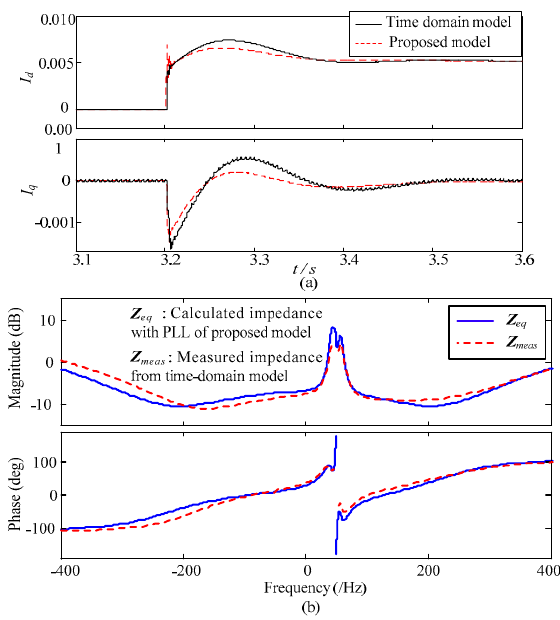
Figure 5. The comparison of the time-domain model and the proposed model: ( a ) current step responses; and ( b ) VSC impedance in stationary frame.